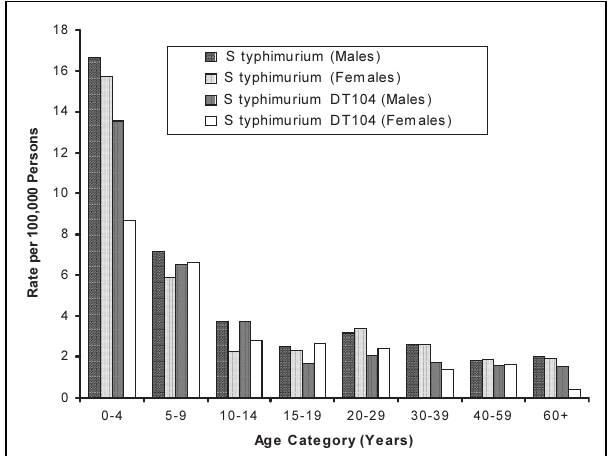
Figure 1) Distribution, by age and gender, of Salmonella serotype typhimurium ( S typhimurium ) and S typhimurium definitive type